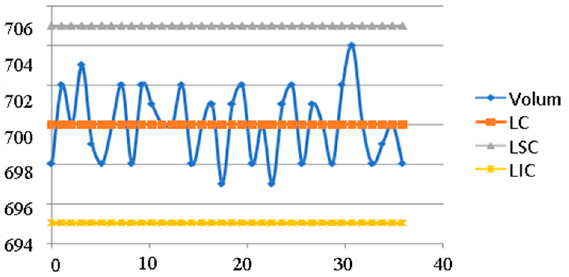
Figure 6. Control diagram for the filling degree of Metaxa bottles. V = 700 mL.